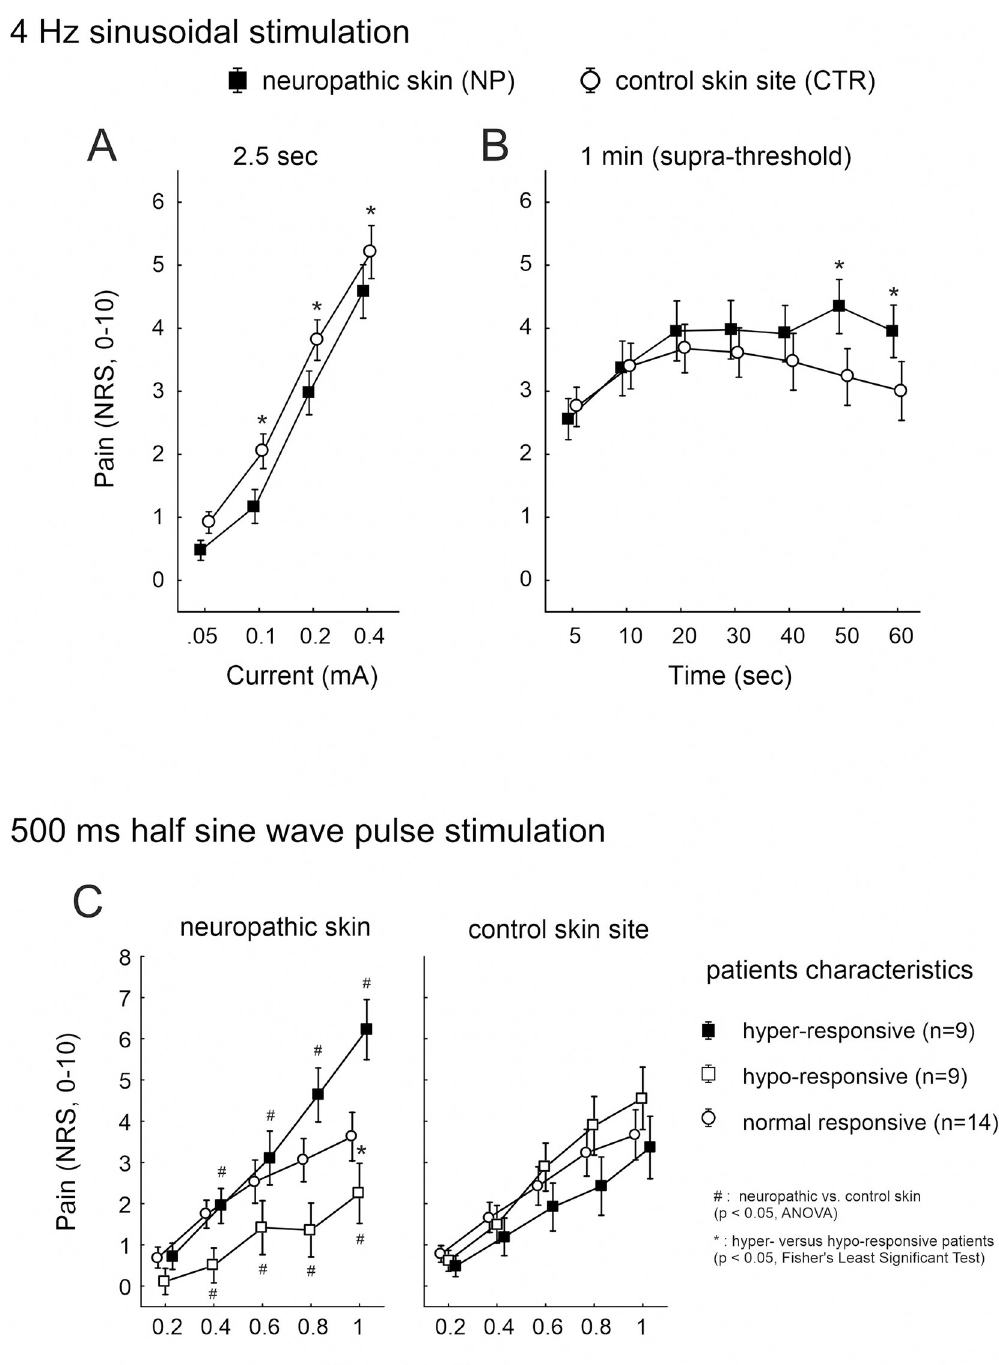
Fig 1. Pain to 4 Hz sinusoidal and 500 ms half sine wave stimulation. Electrically evoked pain (NRS, 0–10) recorded from the neuropathic (solid squares) and control (open circles) skin sites of 33 patients upon (A) 2.5 sec 4 Hz sinusoidal pulses of 0.05 to 0.4 mA, and (B) upon continuous (1 min) 4 Hz sinusoidal stimulation of supra-threshold intensity. (C) Pain recorded from neuropathic (left panel) and control skin (right panel) in response to 500 ms single half sine wave pulses of 0.2 to 1 mA intensity. Patients that reported increased pain at neuropathic compared to control skin sites upon stimulation (delta NRS > 1) were grouped “hyper-responsive” (solid squares), patients with less sensitivity (delta NRS < -1) “hypo-responsive” (open squares), and patients without NRS differences between the sites (delta NRS < 1and > -1) classified “normal” (open circles). Hash symbols indicate significant differences between neuropathic and control skin (p < 0.05, ANOVA), asterisks indicate significant post-hoc comparisons between the patients’ groups (p < 0.05, Fisher’s Least Significant Test).